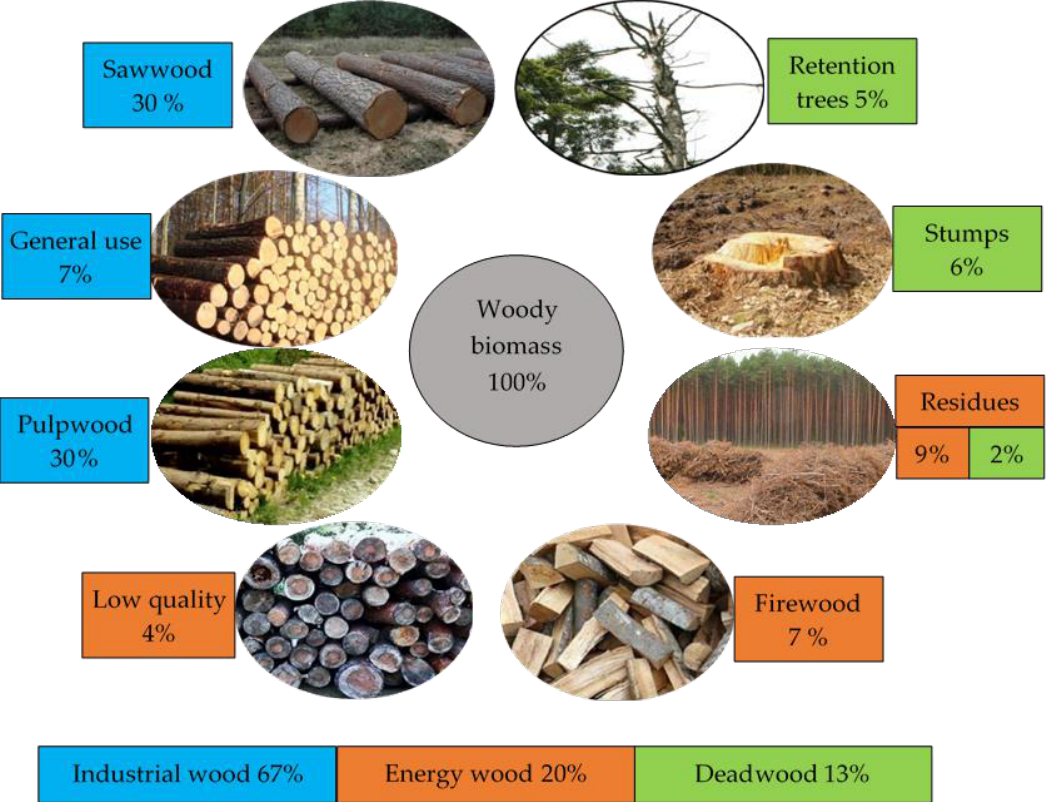
Figure 1. The balance and hierarchical use of the woody biomass according to economic and eco- logical